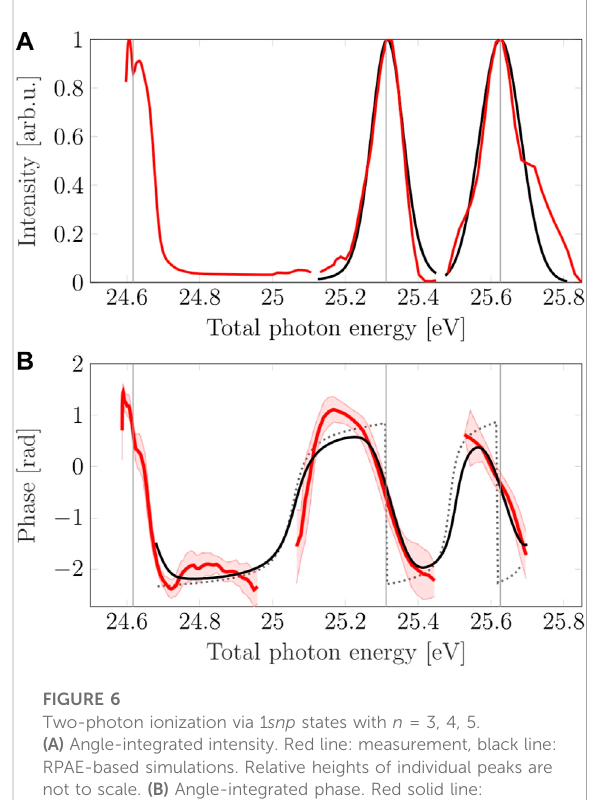
FIGURE 6 Two-photon ionization via 1 snp states with n = 3, 4, 5. (A) Angle-integrated intensity. Red line: measurement, black line: RPAE-based simulations. Relative heights of individual peaks are not to scale. (B) Angle-integrated phase. Red solid line: measured data, shaded areas: error of the weighted average. RPAE-based simulations excluding (grey dashed line) and including (black solid line) the effect of the pulse bandwidth and power-induced broadening ( γ p = 10 meV). Vertical grey lines indicate the energies corresponding to the 1 snp 1 P 1 resonances with n = 3, 4, 5.